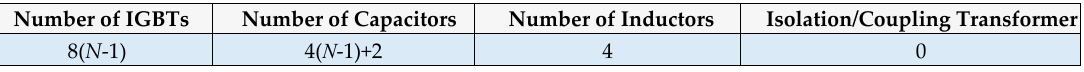
Figure 16. Number of SMs connected to the output terminals: ( a ) HB-MMC4; and ( b ) HB-MMC2. Table 12. Components quantities of the HB-MMC2 RPC.